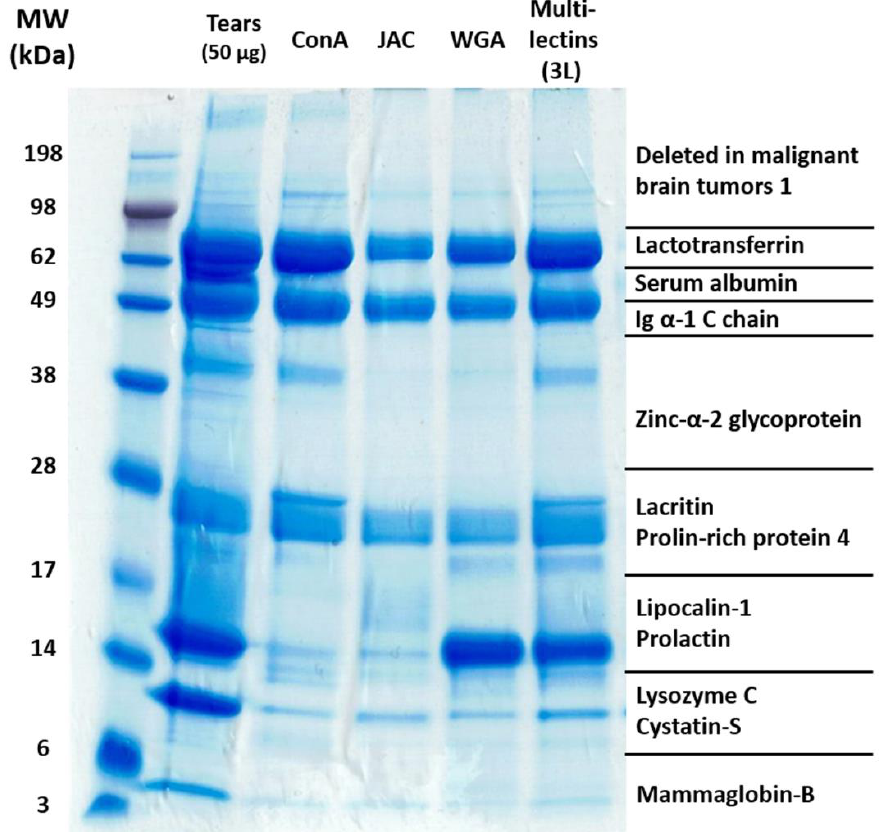
Figure 2. The 1D gel electrophoresis and Coomassie protein staining of potentially enriched glycoproteins from human tear sample pools. The image shows the eluate fractions of single-lectin columns (ConA, JAC, and WGA) and the multi-lectin column device (combination of ConA, JAC, and WGA, termed 3L). An untreated tear sample pool (50 µg) was included in this experiment to match potentially enriched glycoproteins with the native tear film proteome. The most abundant protein markers were labeled in the respective mass range.